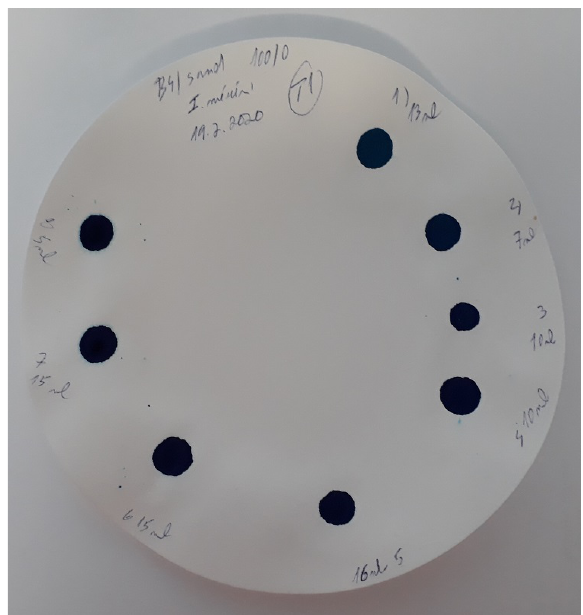
Figure 2. A drop of the mixture is placed on a filter paper.